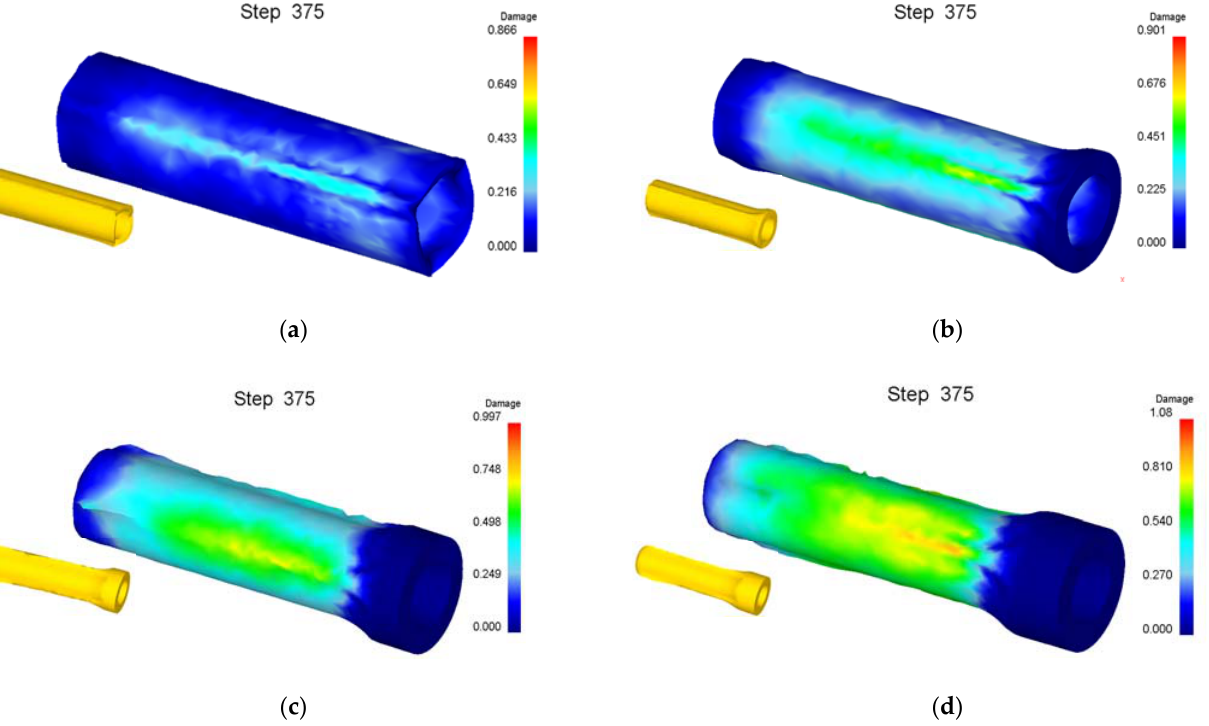
Figure 6. Damage value distribution of roll formed cups by billets with different wall thicknesses of ( a ) 22 mm; ( b ) 26 mm; ( c ) 30 mm; ( d ) 34 mm.